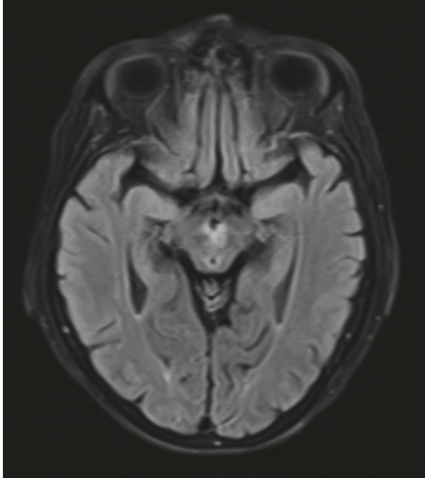
Figure 2: MRI brain with fluid attenuated inversion recovery (FLAIR) series demonstrating the “V sign” hyperintensity along the pial surface of the interpeduncular fossa in the